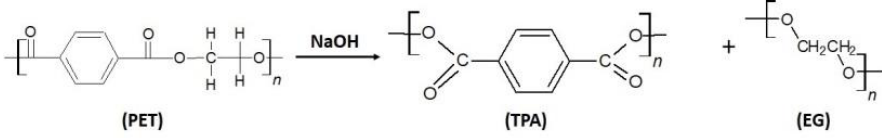
Figure 3. DSC scans of the whole thermal cycle—first heating (1°), cooling (2°), and second heating Scheme 1. Suggested PET breakdown molecules upon contact with NaOH. (3°). Compounds indicated. Heating/cooling/reheating rates of 10 °C/min.